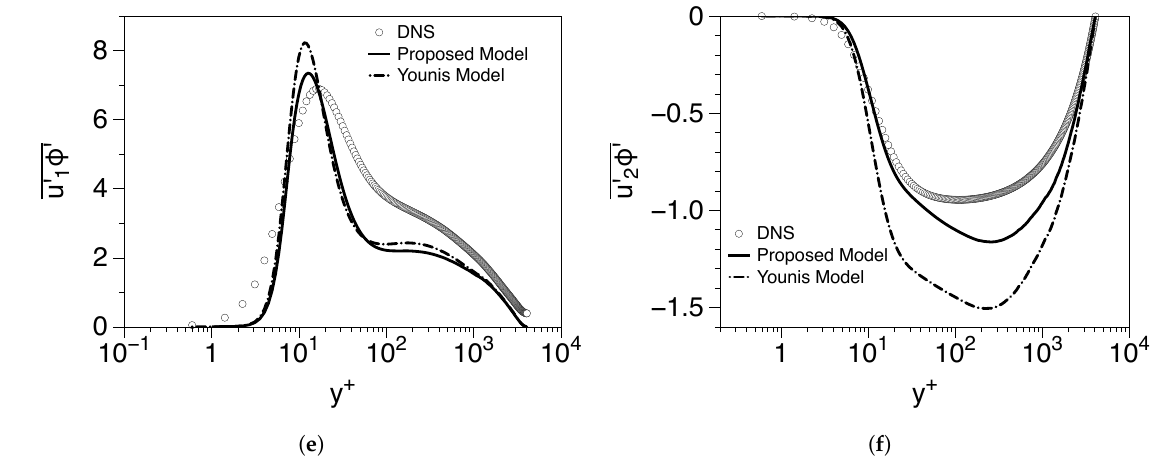
Figure 4. Model predictions for the scalar-flux components for a channel flow: Re τ = 955 ( a , b ), Re τ = 2013 ( c , d ), and Re τ = 4088 ( e , f ).